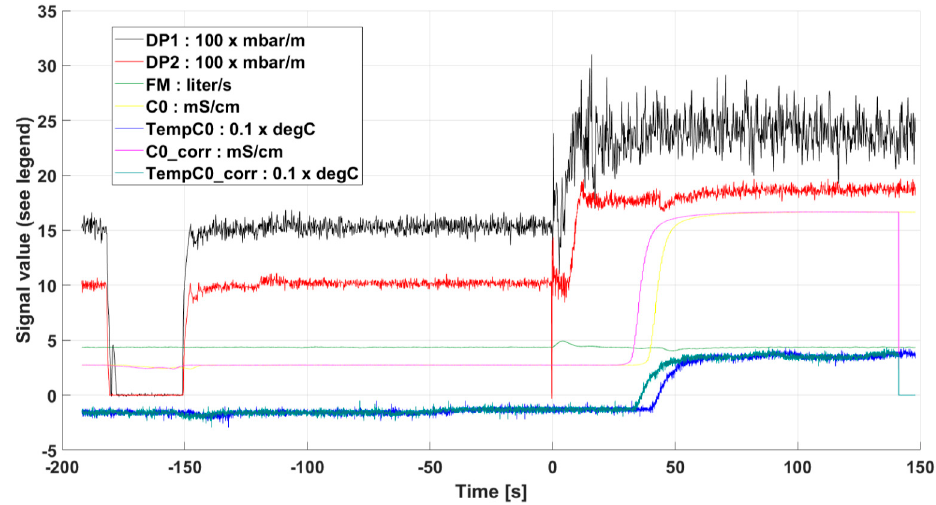
Figure 14. Experiment in concentric annulus with 60 degrees well inclination. Time traces of pressure gradients (DP1: black, DP2: red), flow rate (FM: green), conductivity of mixed fluid downstream of test section (C0: yellow), and temperature of mixed fluid downstream of test section (T0: blue).